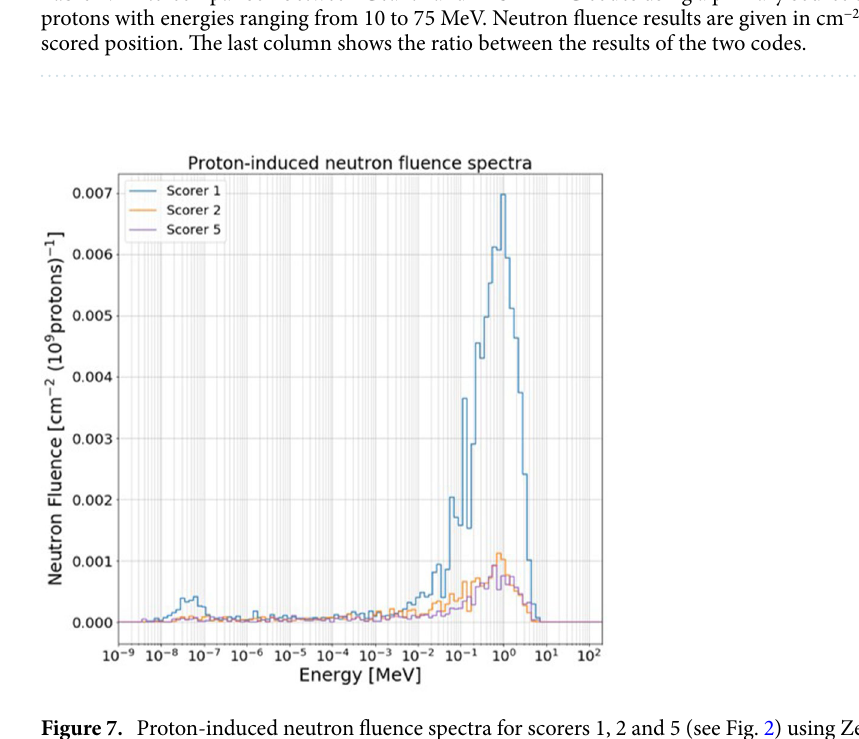
Figure 7. Proton-induced neutron fluence spectra for scorers 1, 2 and 5 (see Fig. 2) using Zeil2010 input parameters. Values are normalized to 10 9 primary